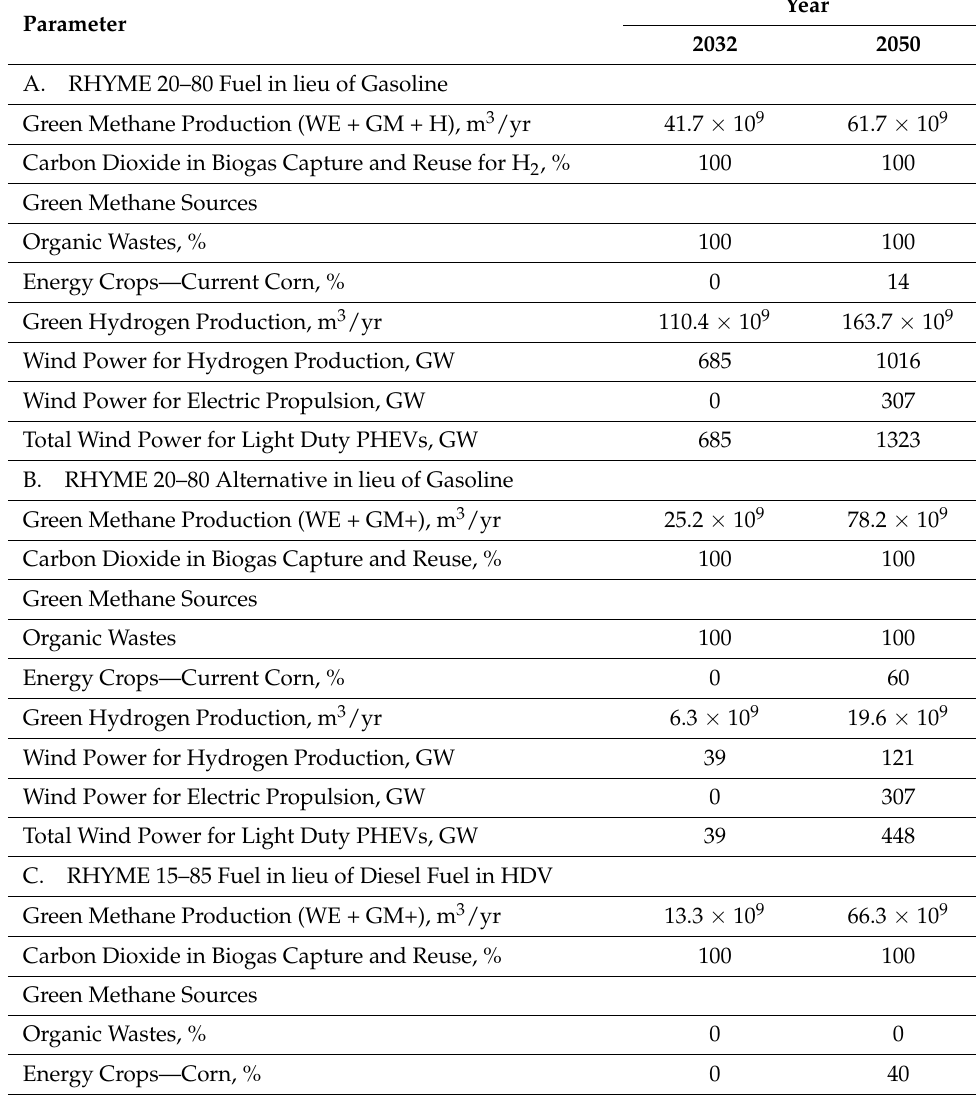
Table 10. Long term development of green hydrogen in transportation through the implementation of the RHYME fuels in the United States and PHEV/HEV technologies to replace gasoline and diesel fuels.